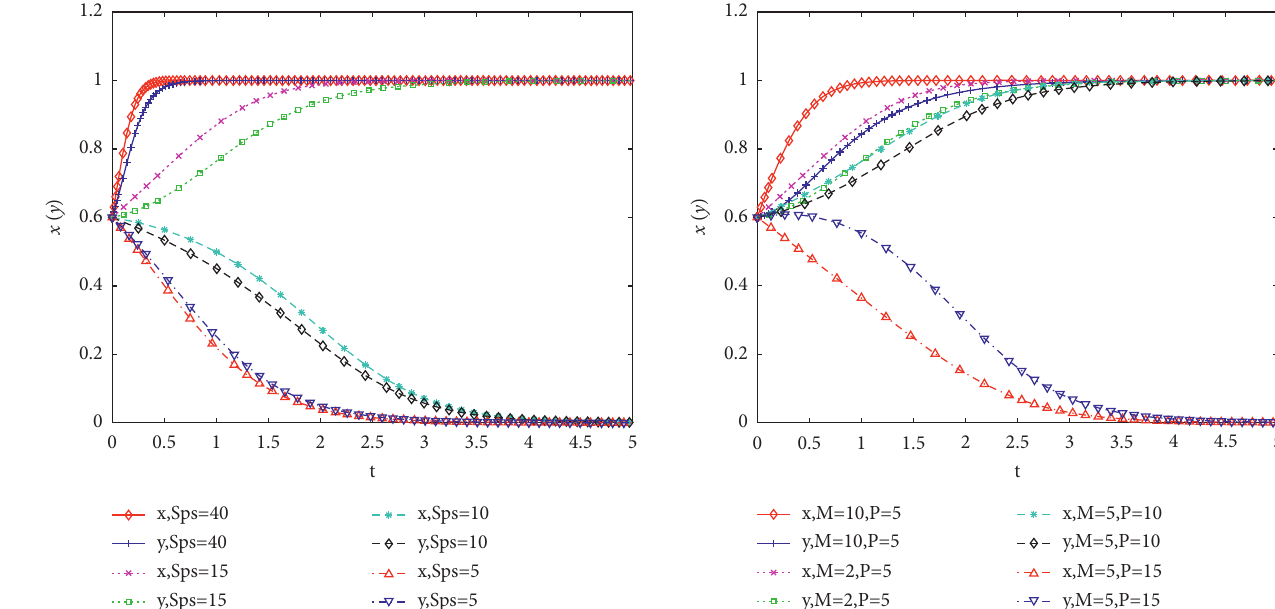
Figure 10: The stability analysis of Model II under different S